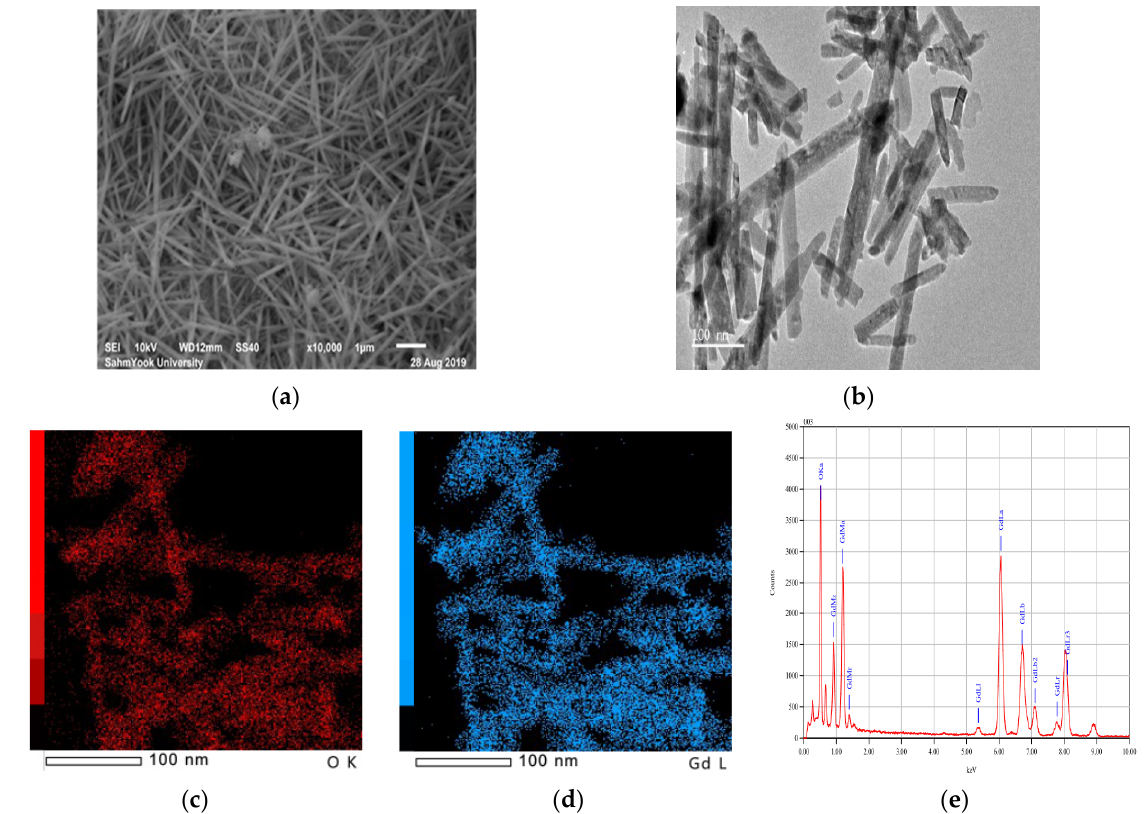
Figure 3. Morphological analysis ( a ) SEM images and ( b ) TEM images of the Gd 2 O 3 nanoparticles. Elemental analysis ( c ) and ( d ) EDX mapping composition of the Gd 2 O 3 nanoparticles, ( e ) EDX spectrum of the Gd 2 O 3 nanoparticles, they are kind of elements such as Gd, O.